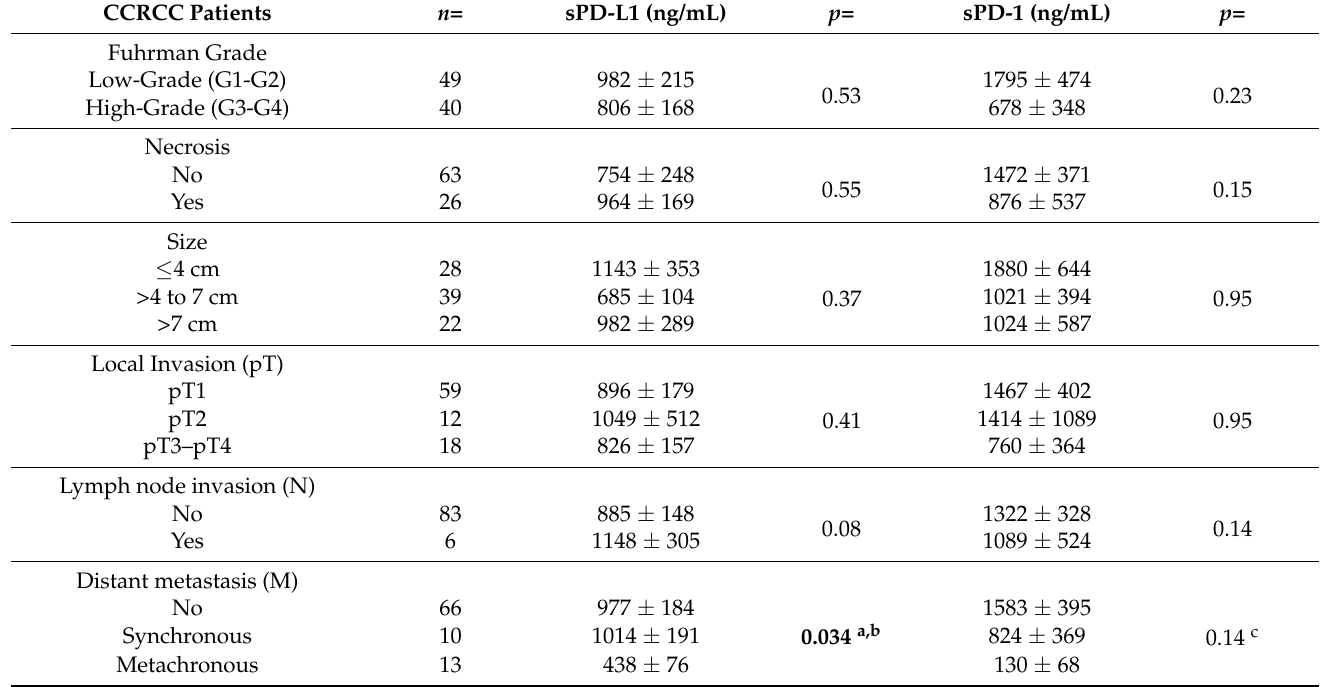
Table 3. Plasma sPD-L1 and sPD-1 levels in terms of pathological parameters of CCRCC aggressiveness. The Mann-Whitney test was used for comparisons between two groups and Kruskal-Wallis for more than two groups. Values are represented as means ± standard errors. a sPD-L1 synchronous vs. No, Mann-U p = 0.038; b sPD-L1 synchronous vs. Metachronous, Mann-U p = 0.008; c sPD-1 synchronous vs. Metachronous, Mann-U p = 0.037. Statistically significant values are highlighted in